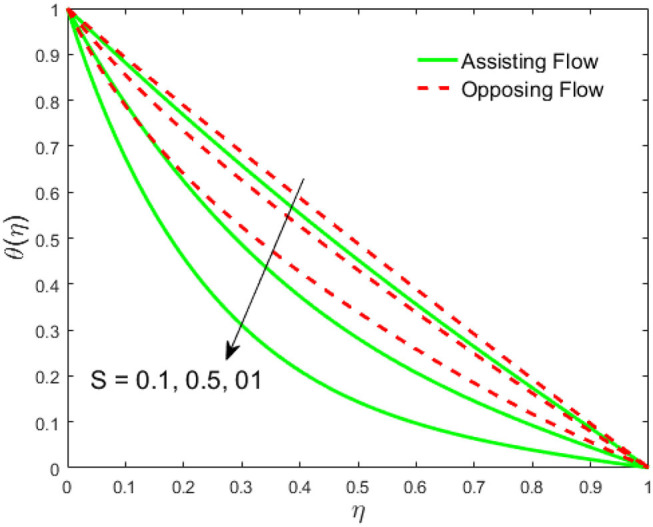
Impact of S on θ(η).